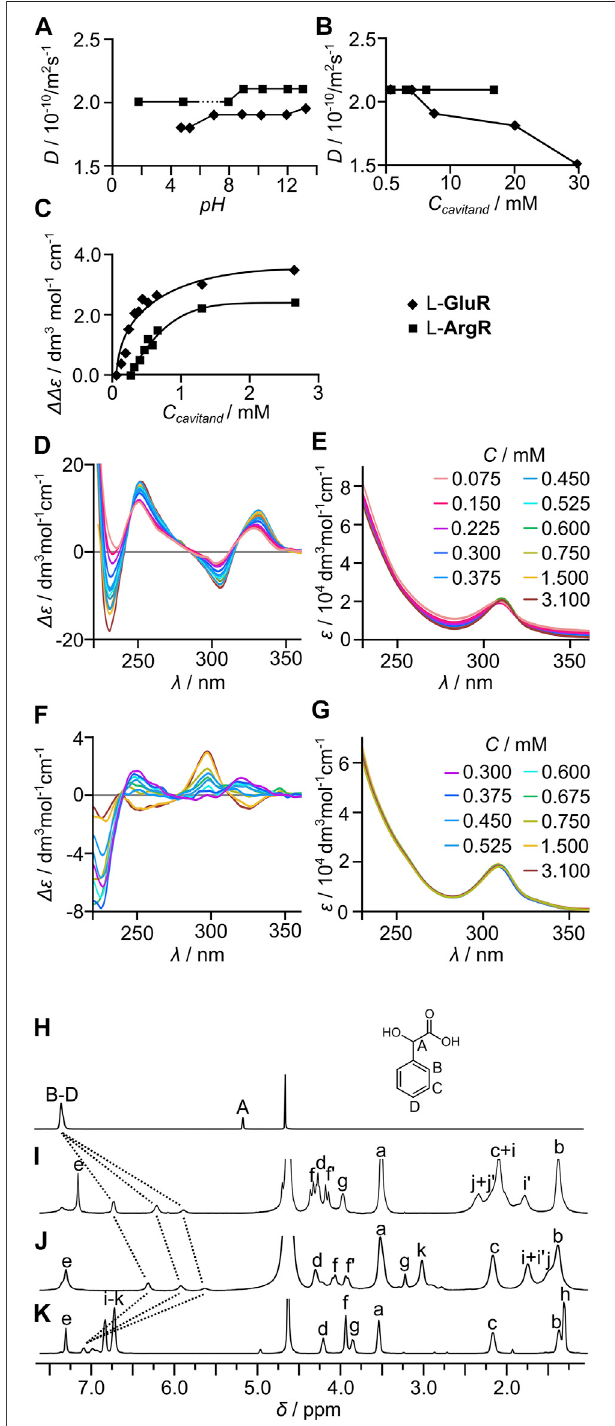
FIGURE 2 | Self-assembly of homocapsules (L- GluR ) 2 and (L- ArgR ) 2 in water. Diffusion coef fi cients ( D , measured by DOSY) of (L- GluR ) 2 and (L- ArgR ) 2 inwater: (A) at various pH (C = 10 mM); and (B) atvarious concentrations (pH = 4.8). Concentration-dependent CD and UV spectra: (C) a plot of concentration-dependent intensity of CD bands for L- GluR and L- ArgR (water, pH=11.9); (D) CDforL- GluR ; (E) UVforL- GluR ; (F) CDforL- ArgR ;and (G) UV